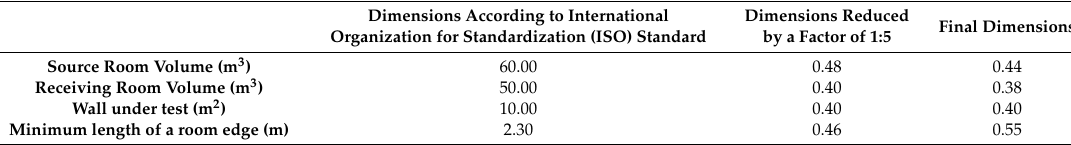
Table 1. Data from the design of the chamber and the final